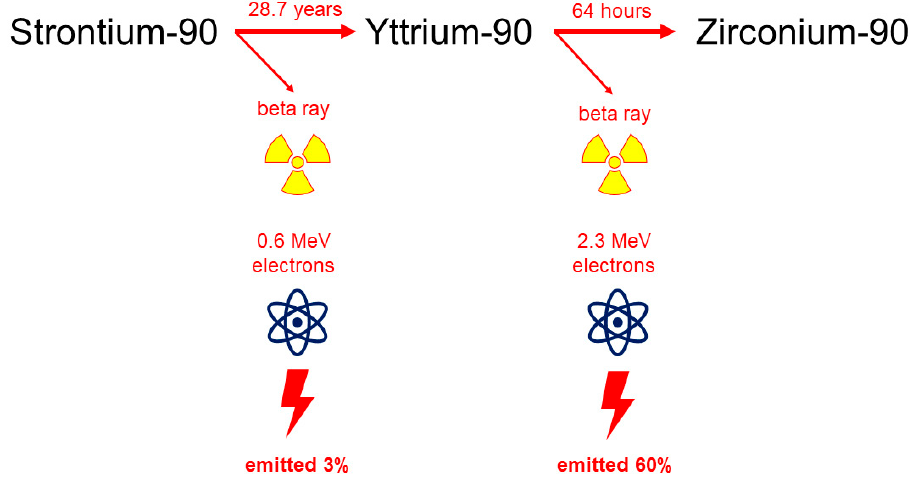
Figure 3. Stronium-/Yttrium-90 beta-irradiation decay scheme.